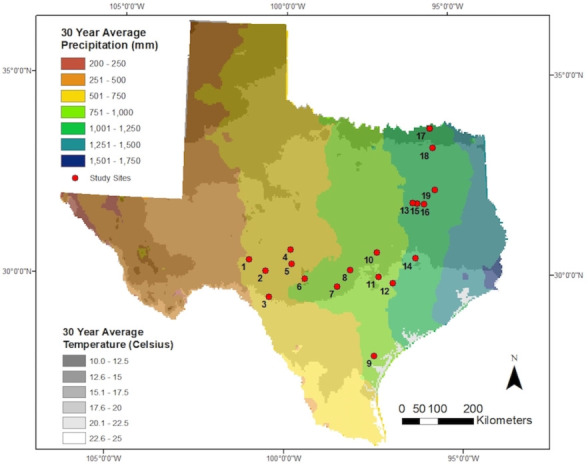
Locations of grassland study sites (n = 19) in relation to long-term environmental conditions in Texas.Precipitation and temperature gradients are 30-year annual averages from 1981–2010 adapted from open access data through PRISM Climate Group [27], across Texas. Ecoregion classification, latitude, and longitude for each site are listed in S1 Table.